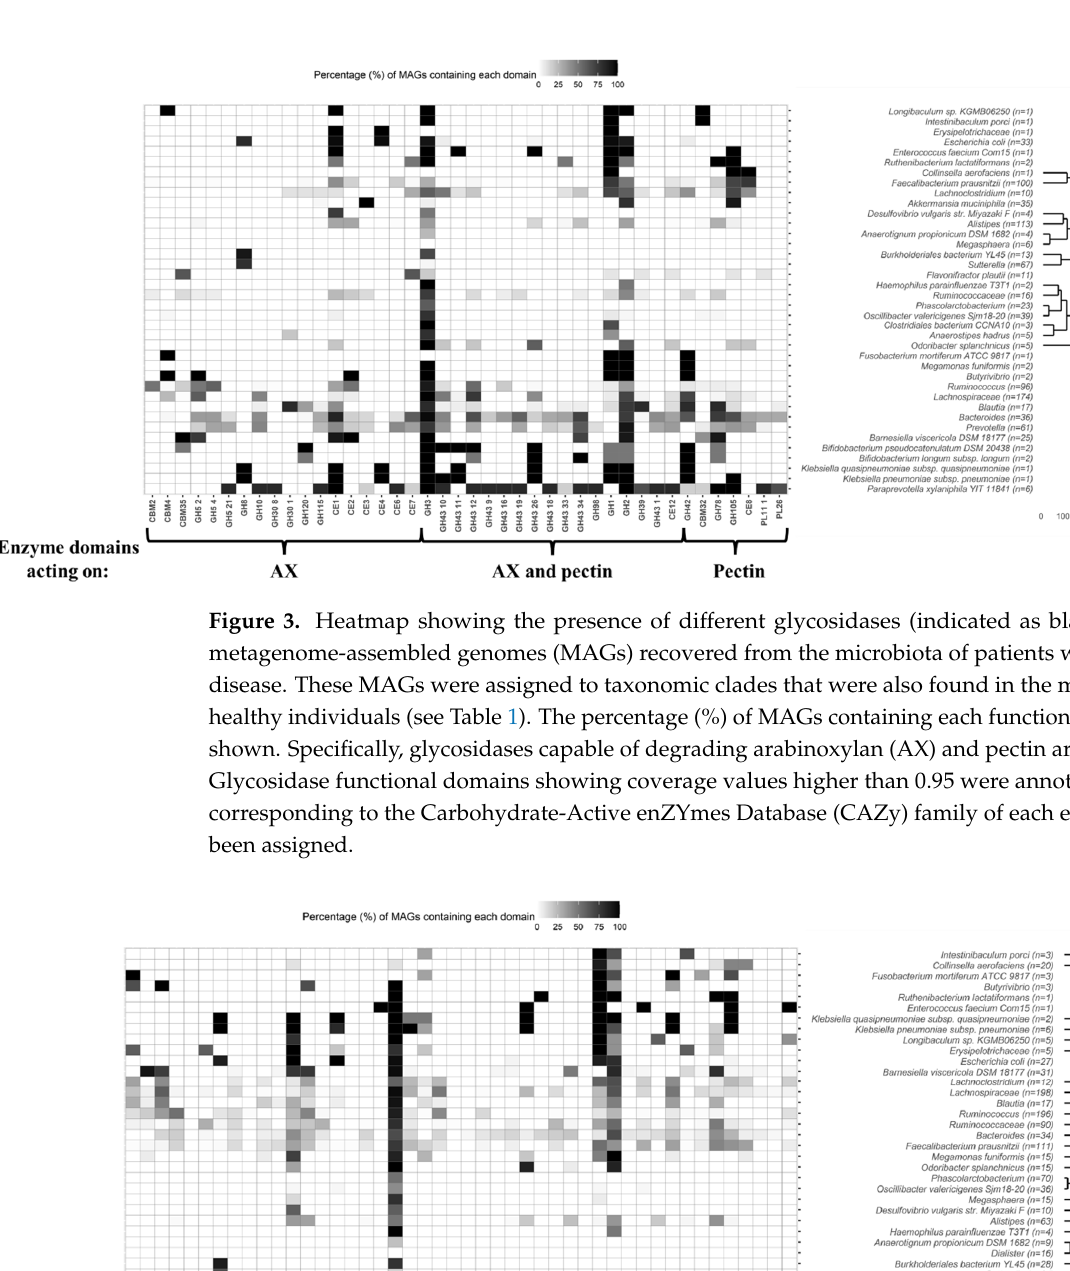
Figure 2. Schematic representation of enzyme domains acting on arabinoxylan and pectin that were annotated in metagenome ‐ assembled genomes (MAGs) recovered from the microbiota of patients with Crohn’s disease and healthy individuals.